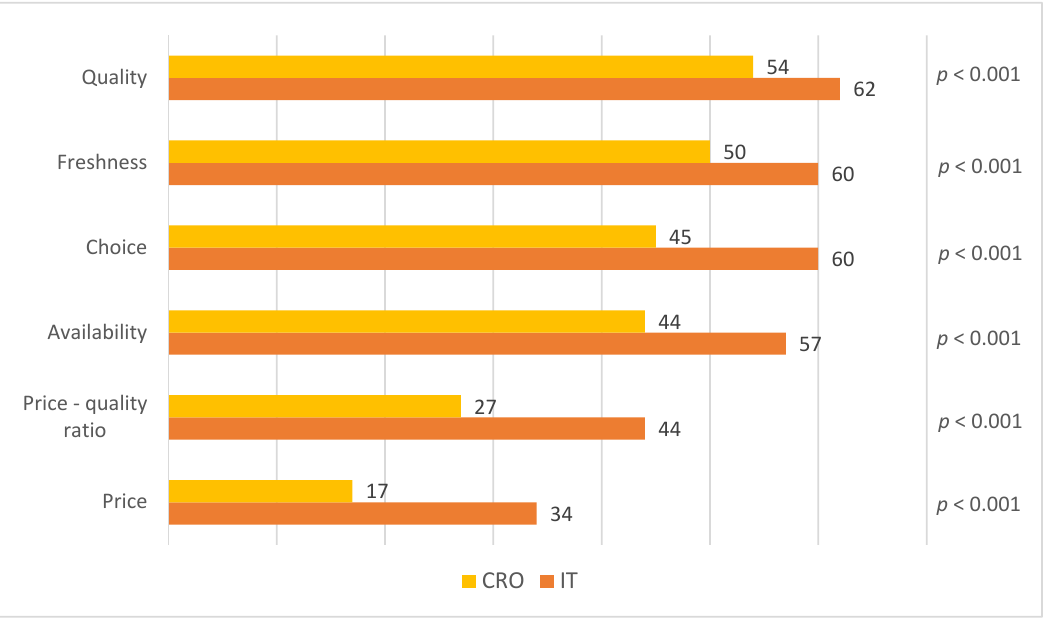
Figure 1. Participants’ ranking of satisfaction with product attributes in Croatia and Italy (% of participants).